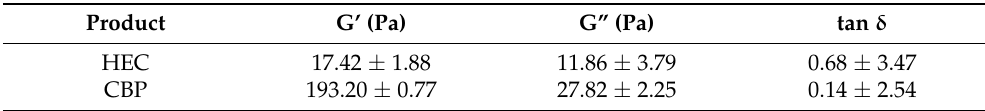
Table 2. Amplitude sweep test data of formulation with hydroxyethylcellulose (HEC) and formula- tion with carbopol (CBP) at a temperature of 25 ◦ C and at a shear strain value of 1%. The results are presented as averages and relative standard deviations in percentage (RSD